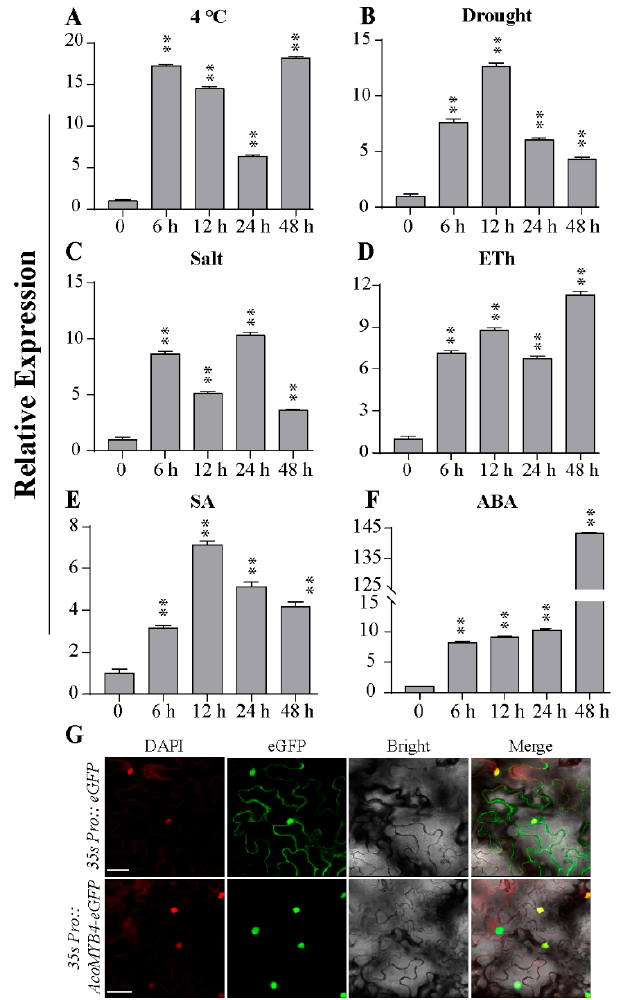
Figure 2. Expression patterns and subcellular localization of AcoMYB4. Relative expression levels of AcoMYB4 under different treatments: ( A ) cold, ( B ) drought, ( C ) salt, ( D ) Eth, ( E ) SA, and ( F ) ABA. For each treatment, the expression level at 0 h was set as 1.0 and values are means of three replicates. ( G ) AcoMYB4 subcellular localization was shown in Nicotiana Benthamiana leaves’ surface cells, Bar = 5 μ m. The error bars indicate + SD ( n = 3). Asterisks indicate significant differences for the indicated comparisons based on Student’s t-test (** p < 0.01).